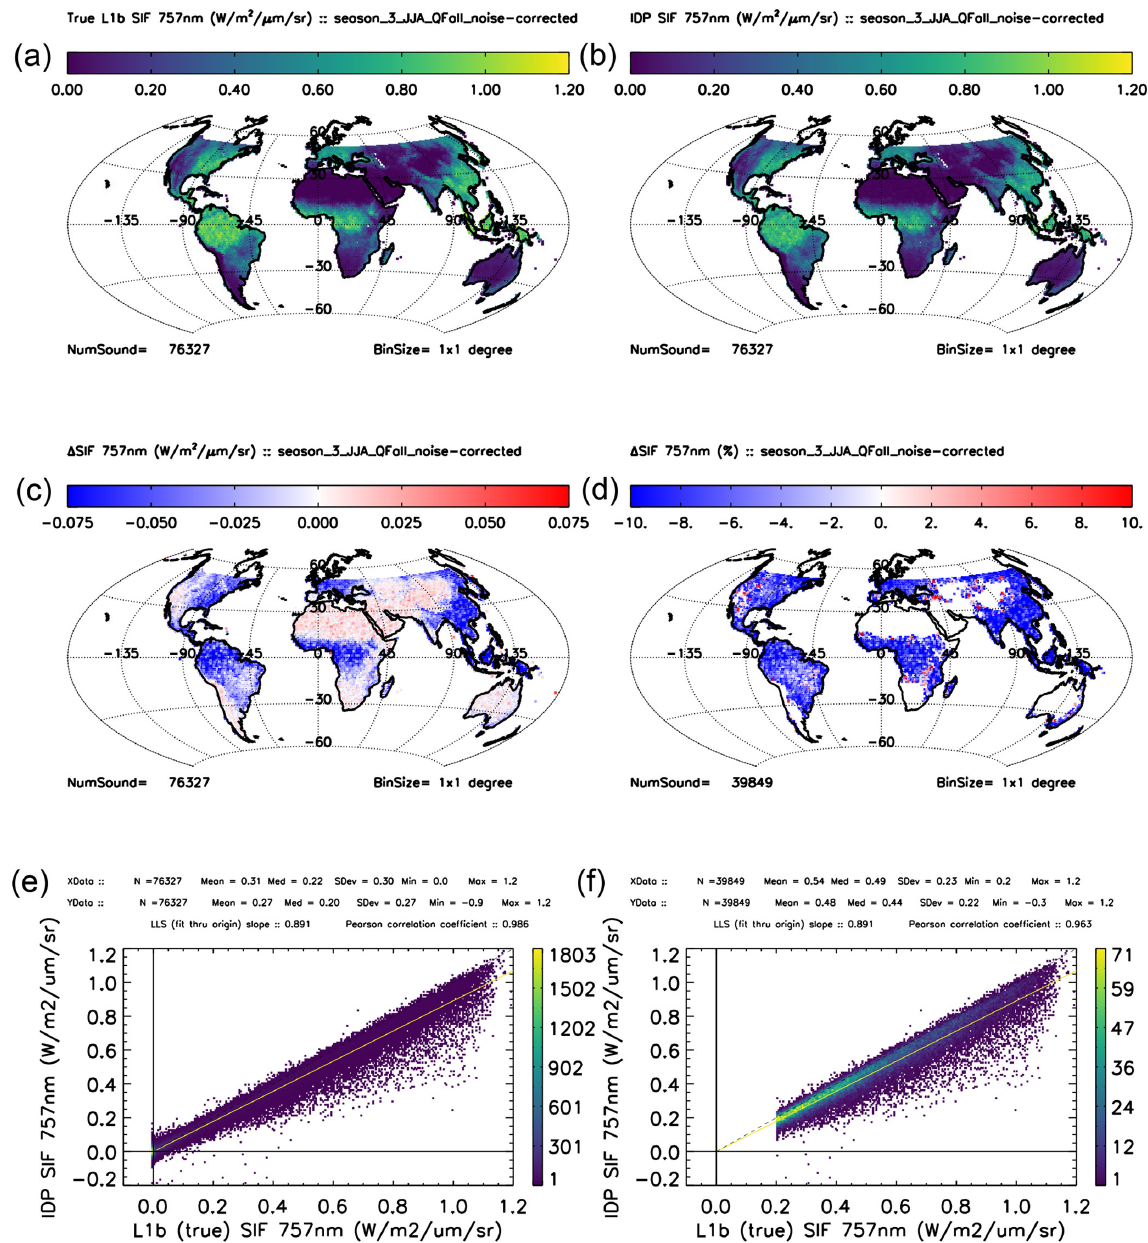
Figure 20. Results comparing the IDP-retrieved and true L1b SIF. These results are from cloudy conditions with noise-corrected SIF at 757nm. Panels (a, b) and (c, d) show maps gridded to 1 ◦ by 1 ◦ for the JJA soundings assigned a good QF. The true L1b values (a) and the corresponding IDP-retrieved values (b) are both in units Wm − 2 µm − 1 sr − 1 . The absolute difference between the retrieved and true values (c) and the fractional difference after an additional screening on true SIF > 0 . 2 (d) . The linear correlation, along with some basic statistics for the full JJA set (e) and the subsetted data (f)